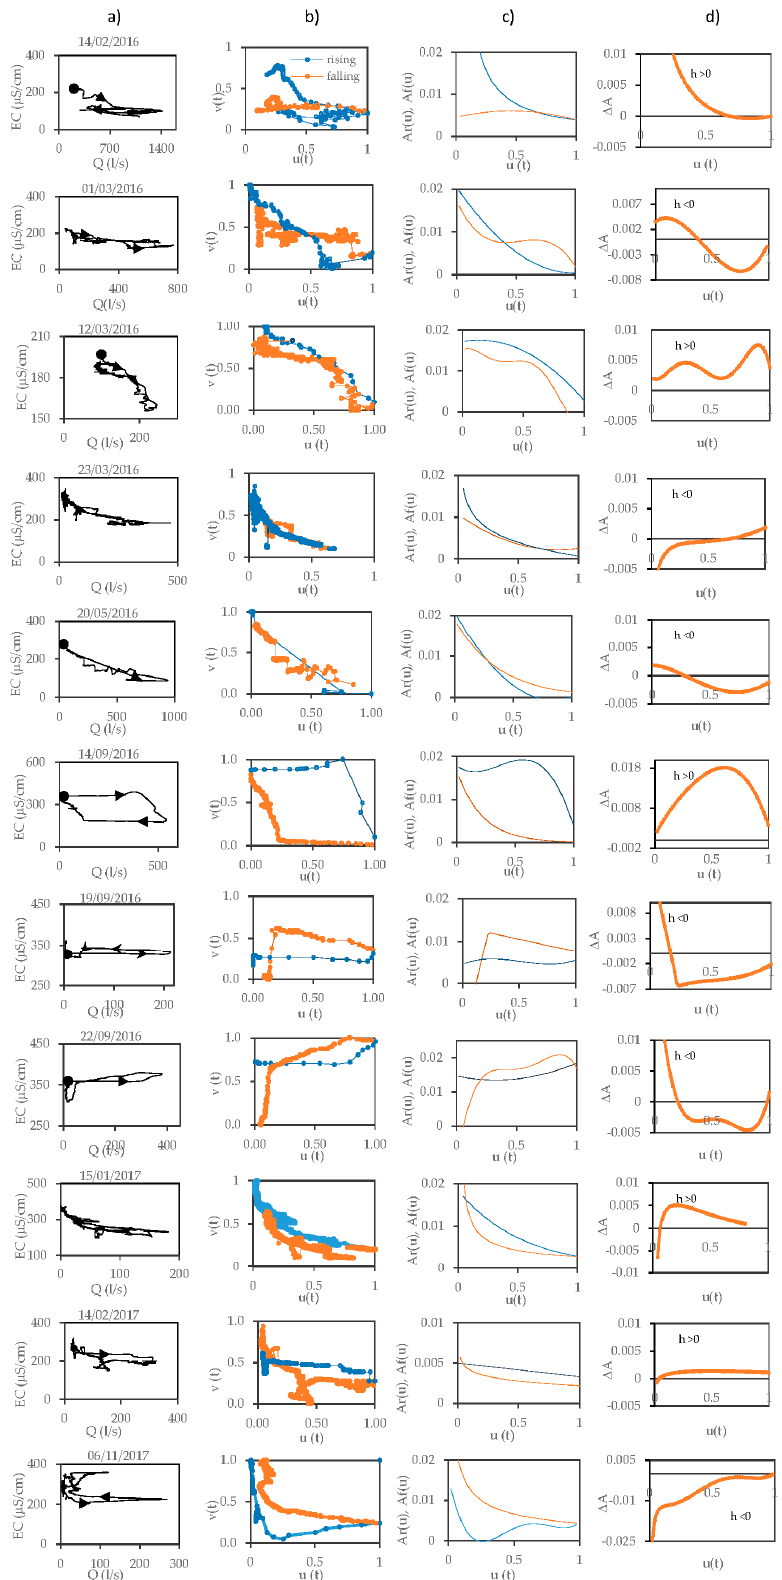
Figure 12. Hysteretic index results estimated with the formulation of [25]. ( a ) hysteretic loops of the events; ( b ) Normalization of the Q and EC parameters; ( c ) definite integrals Ar[i, j] and Af[i, j] of the functions vr(u) and vf(u) on intervals [i, j] for the rising (r) and the falling (f) curve; ( d ) di ff erences between the definite integrals on the rising and falling curves computed for the same intervals, [i,